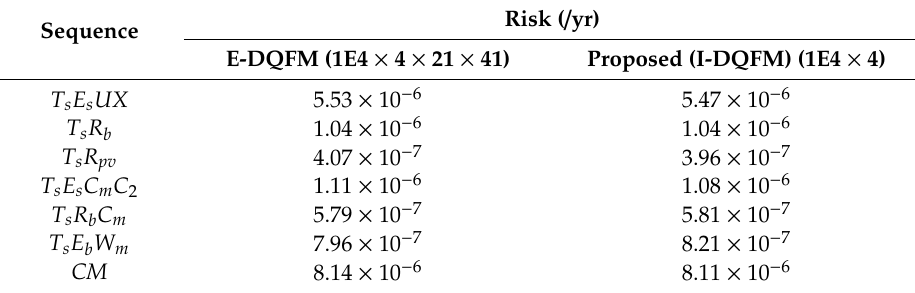
Figure 16. Comparison of multi-hazard system fragility results (“CM sequence”) regarding the LGS NPP example ((3) partially dependent condition): ( a ) E-DQFM; ( b ) proposed (I-DQFM). Table 9. Mean multi-hazard risk for “LGS NPP”: Partially correlated case.